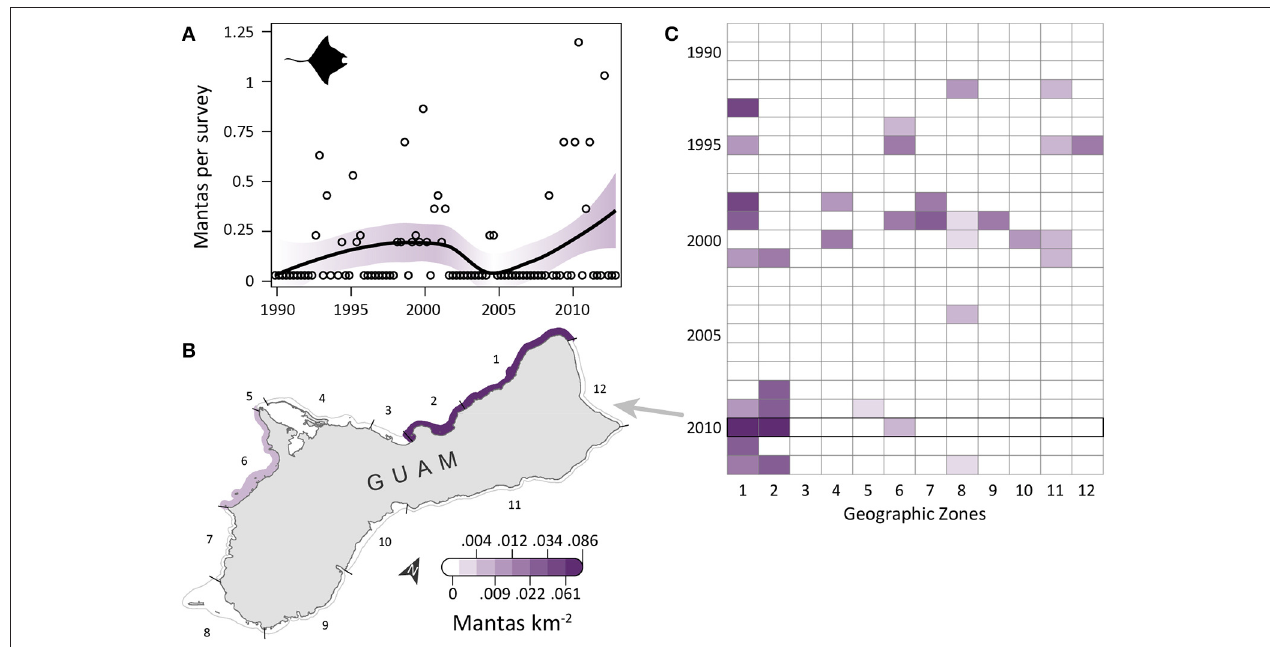
FIGURE 3 | Infrequent, increasingly aggregated manta ray observations on Guam’s reefs since 1989. (A) Trend in manta ray observations from semimonthly aerial surveys conducted by Guam Division of Aquatic and Wildlife Resources (DAWR). Observations (manta rays) per survey (OPS) by quarter are depicted with open circles. Model fit with shaded 95% confidence interval suggests observations became slightly more common over time. Mean population growth rate (PGR) was 0.19 ( SD = 0.61, CV = 321%), but should be viewed with caution due to the low number of observations. (B) Map of observed densities for 2010, the year with the highest annual OPS; densities were high in the northwest (zones 1–2) and low elsewhere. (C) Since 2008, most observations were in the northwest, with a few sightings in the southwest (zones 5, 6, and